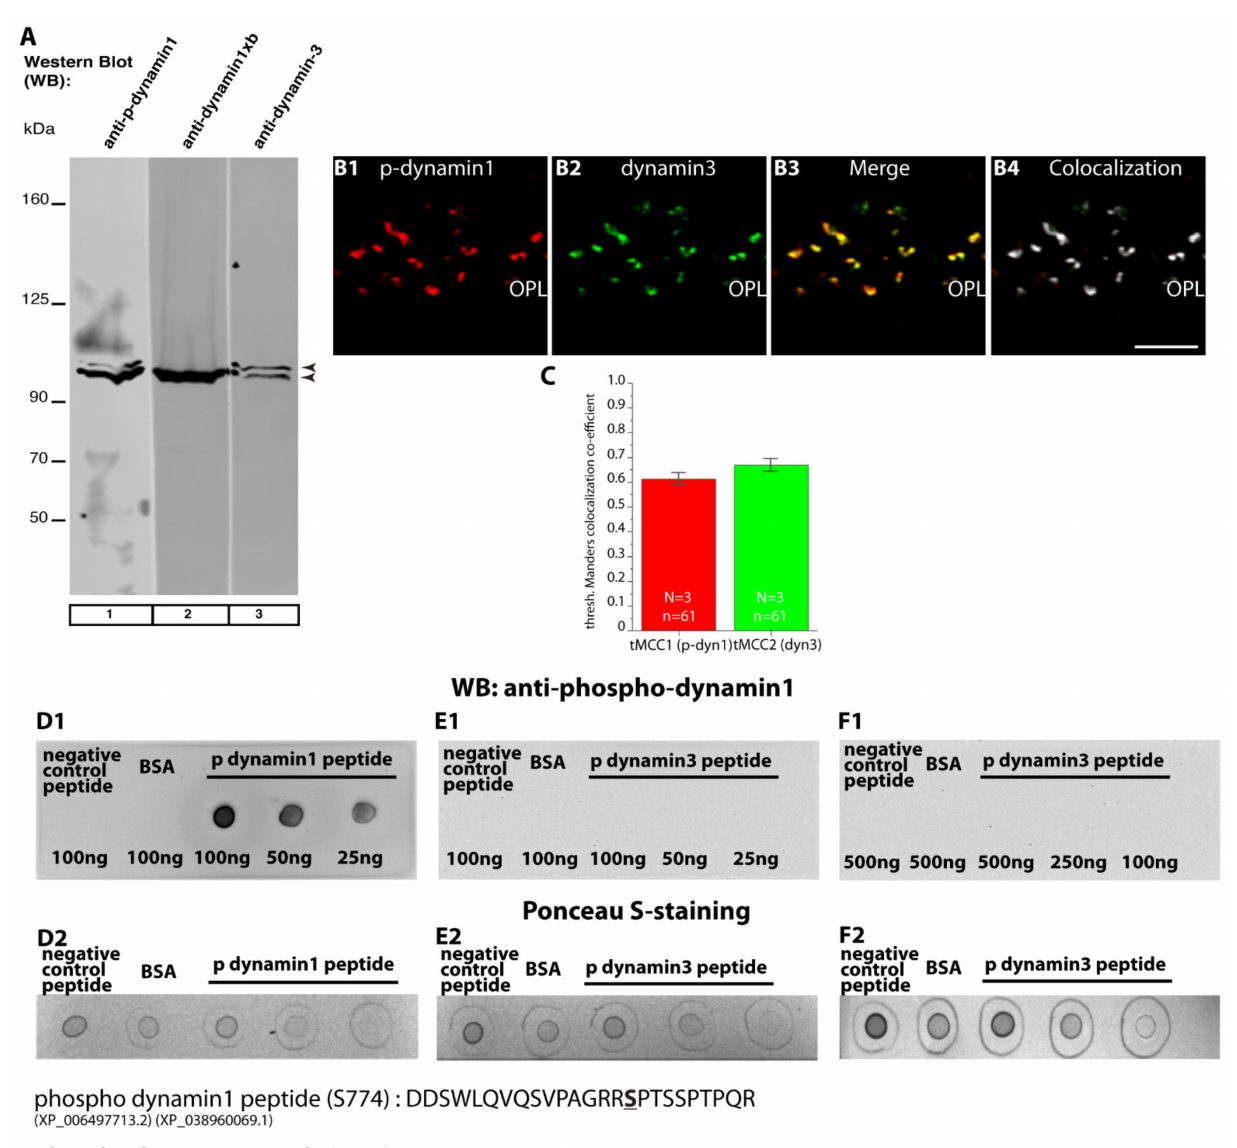
Figure 15. Characterization of different dynamin antibodies and their possible cross-reactivity and co-localization. ( A ) Western blot (WB) analyses of the indicated dynamin antibodies on retinal lysates of un-treated wild-type C57BL/6 mice. ( B1 – B4 ) Confocal images of semi-thin sections from untreated wild-type retina showing the OPL that was double- immunolabelled with anti-phospho-dynamin1 and anti-dynamin 3, as indicated. ( C ) Thresholded Manders colocalization coefficients show the degree of colocalization between phospho-dynamin1 and dynamin3 in the OPL. ( D1 – F2 ) Dot blot analyses were performed to characterize the anti-phospho-dynamin1 antibody for its reactivity with the indicated peptides (p-dynamin1 and p-dynamin3) cross-linked to BSA. p-dynamin1 peptide (DDSWLQVQSVPAGRR S PTSSPTPQR; phospho- serine is underlined and indicated in bold) ( D1 , D2 ) and p-dynamin3 peptide (DDSWLQHSRR S PPPSPTTQR; phospho-serine is underlined and indicated in bold) ( E1 – F2 ) were spotted on nitrocellulose membrane. An unrelated control peptide (CENEIQDLLRAKRELESKLQRLQAQG) cross-linked to BSA as well as BSA only (with no peptide cross-linked to it) were used as negative controls for non-specific antibody binding ( D1 – F2 ). ( D1 ) The anti-p-dynamin 1 antibody strongly reacted with the p-dynamin1 peptide (DDSWLQVQSVPAGRR S PTSSPTPQR). ( E1 , F1 ) The anti-p-dynamin1 antibody did not cross-react with the p-dynamin3 peptide ( E1 ), the negative control peptide ( F1 ), or BSA alone ( D1 , E1 , F1 ). ( D2 , E2 , F2 ) Ponceau-S staining of the respective dot blot nitrocellulose membranes with the spotted cross-linked peptides (spotting controls). Abbreviations: OPL, outer plexiform layer; tMCC, thresholded Manders colocalization co-efficient. Scale bar: 5 µ m ( B